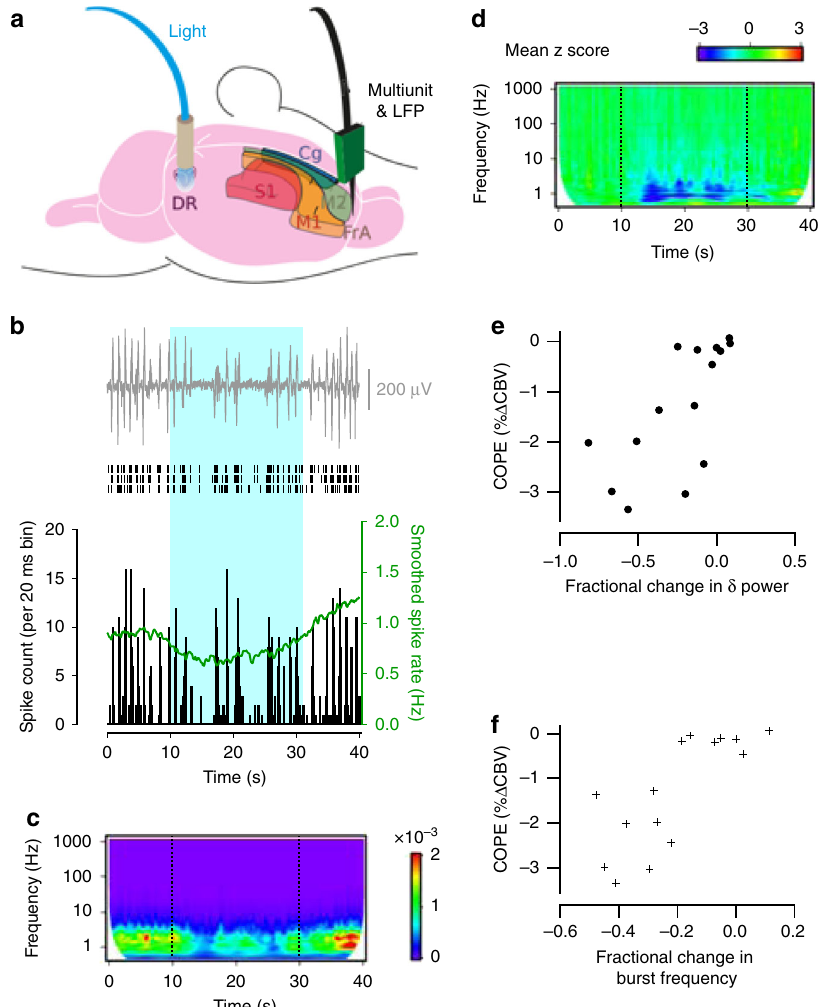
Fig. 3 Photoactivation of DRN 5-HT neurons dampens MUA and LFP power in cortical projection areas. a Schematic of the experimental set-up for paired MUA and LFP recordings in the DRN and projection areas during photostimulation. b Cortical LFP (top), raster plots (middle) of spikes recorded on 3 neighbouring channels and spike time histogram (bottom), reveal reduction in the frequency of cortical network bursts and MUA during optogenetic activation of DRN 5-HT neurons. c Wavelet amplitude spectrum of the cortical LFP averaged over 6 stimulation trials for the experiment shown in ( b ) (warmer colours indicate higher power). Dashed lines indicate onset and end of photostimulation. d Z transform of the wavelet amplitude spectrum averaged across recording sites of mice with robust CBV response to photostimulation, showing a consistent reduction in the amplitude of low-frequency LFP components (8 recording sites from 3 mice). e , f COPEs from various cortical regions correlate strongly with fractional changes in both the d delta power (Pearson r = 0.69; p = 0.004) and e burst frequency (Pearson r = 0.78; p = 0.0006) recorded in 15 recording sites from 7